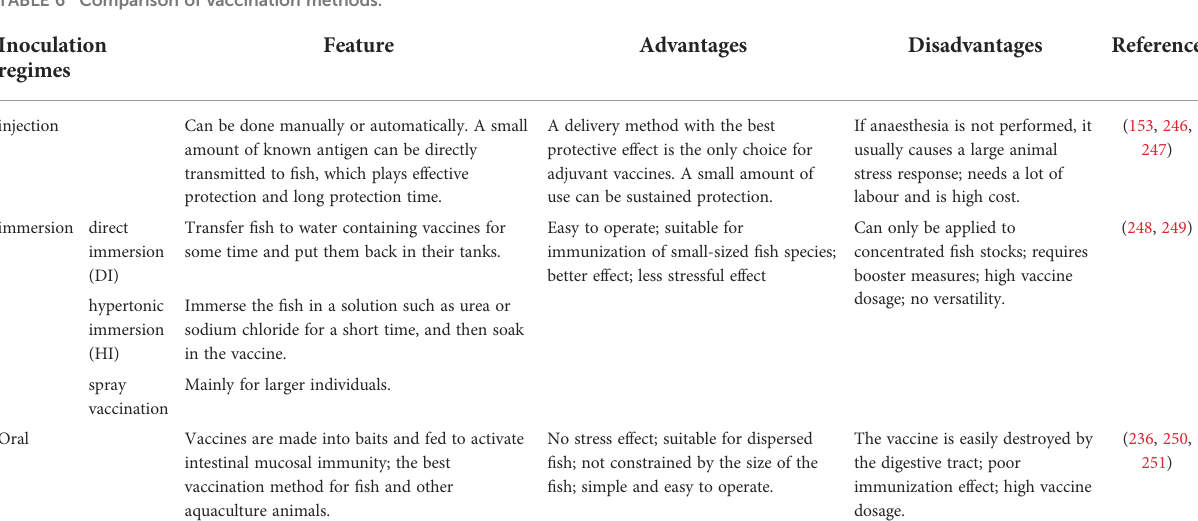
TABLE 6 Comparison of vaccination methods. Inoculation regimes